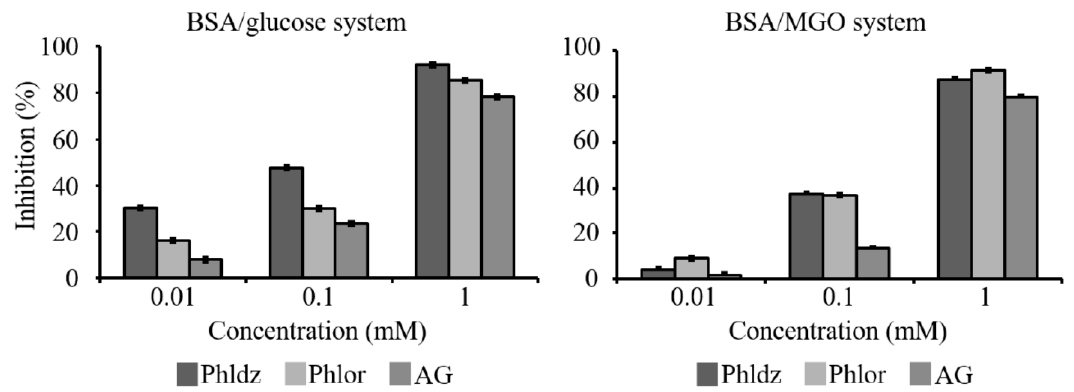
Figure 4. The concentration-dependent inhibitory effects of phloretin, phloridzin (phloretin 2 ′ - O - glucose) and aminoguanidide (AG) against advanced glycation end products (AGEs) formation as measured in bovine serum albumin (BSA)/glucose and BSA/D-glucose, methylglyoxal (MGO) systems.